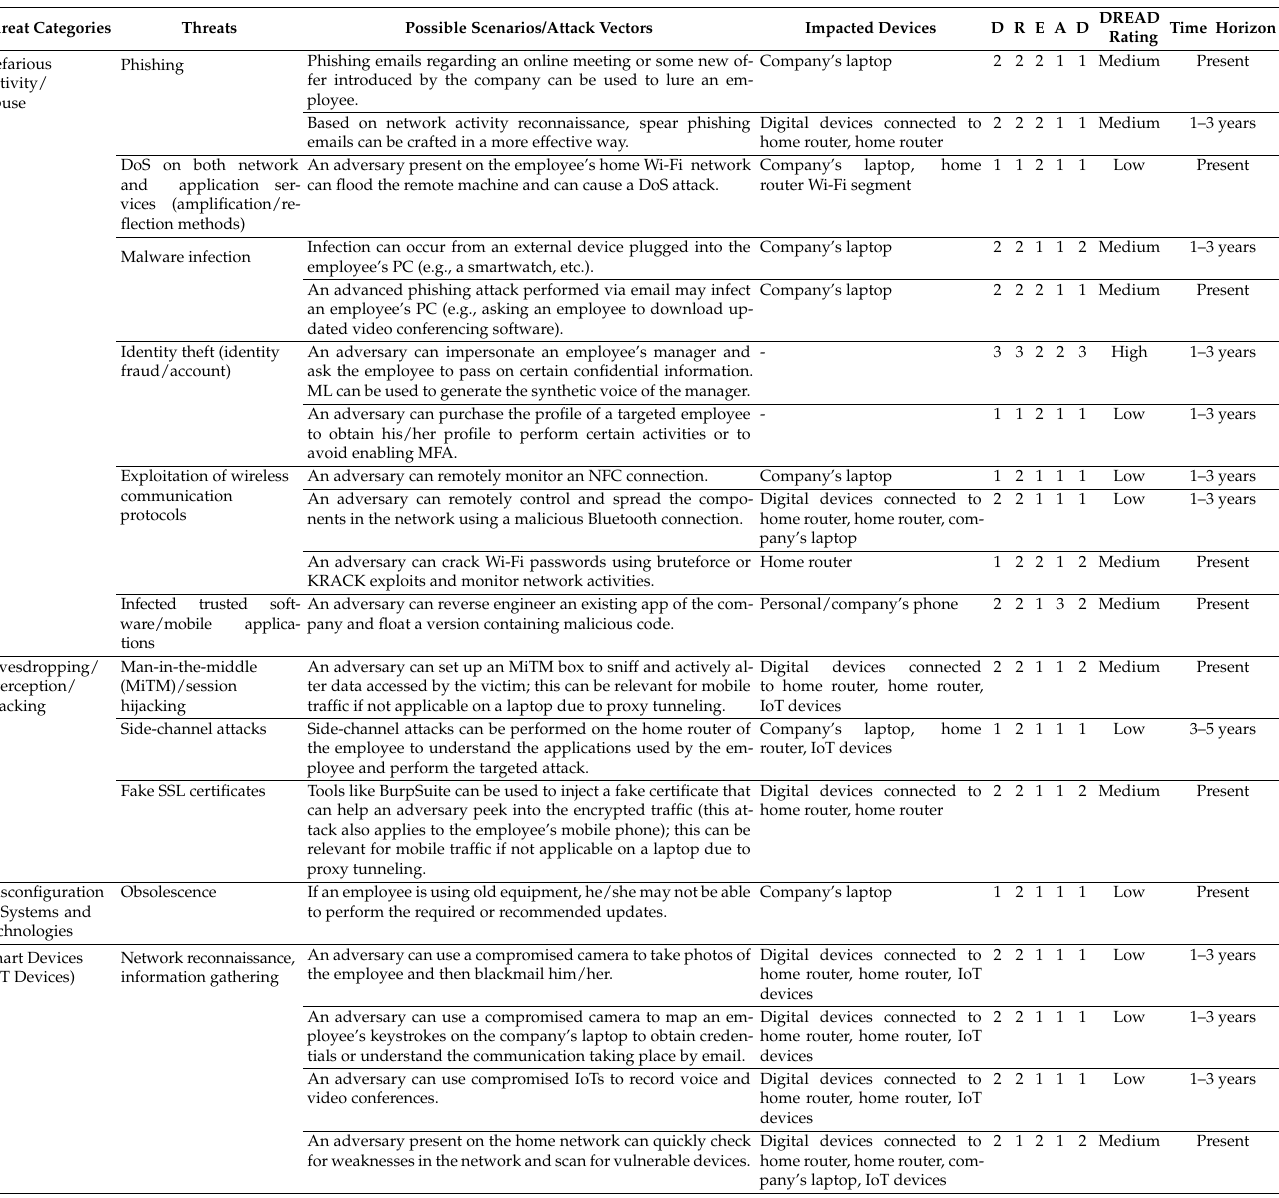
Table A2. High-priority threats and use